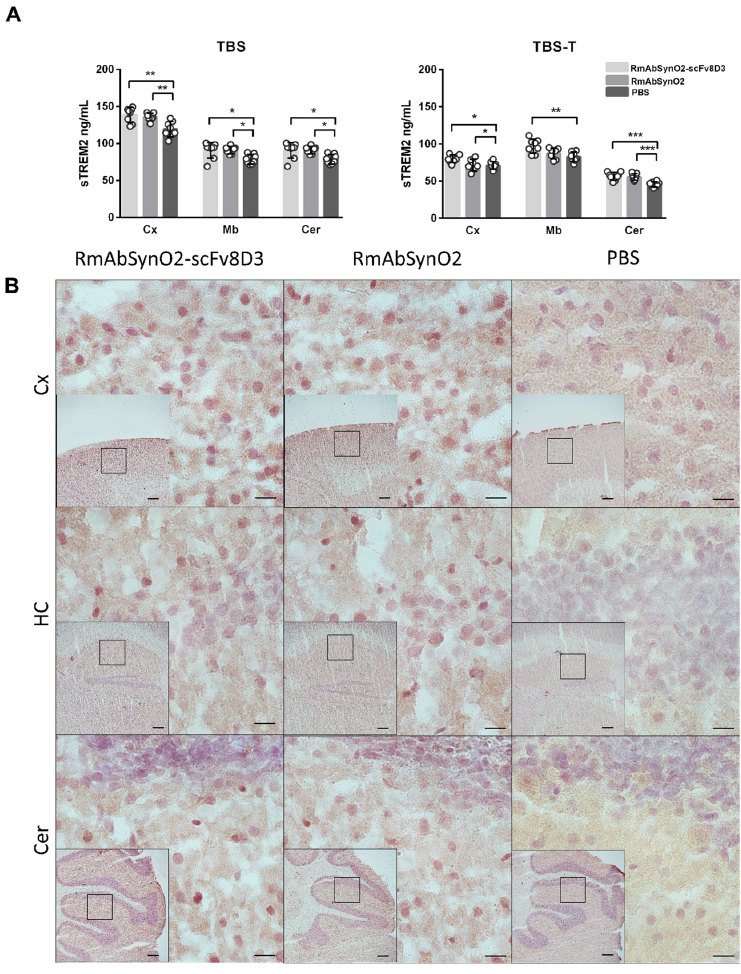
Figure 5. ( A ) ELISA quantification of sTREM2 levels in TBS and TBS-T extracts from the cortex (Cx), midbrain (Mb), and cerebellum (Cer), following treatment with RmAbSynO2-scFv8D3 or RmAbSynO2 in comparison with PBS. Both antibody treatment groups displayed increased sTREM2 levels in both TBS and TBS-T extract of most examined regions. ( B ) Representative images of 20 µ m cryosections stained for Iba1 in Cx, hippocampus (HC), and Cer at 60 × magnification, with 4 × magnifications embedded with squares representing the magnified area, showing increased immunoreactivity on sections from mice treated with both antibody formats. All values are presented as means ± SD, with a one-way analysis of variance followed by Sidak’s multiple comparison test. * p < 0.05, ** p < 0.005, *** p < 0.001. Scale bars: 200 µ m in embedded images, 10 µ m in magnified